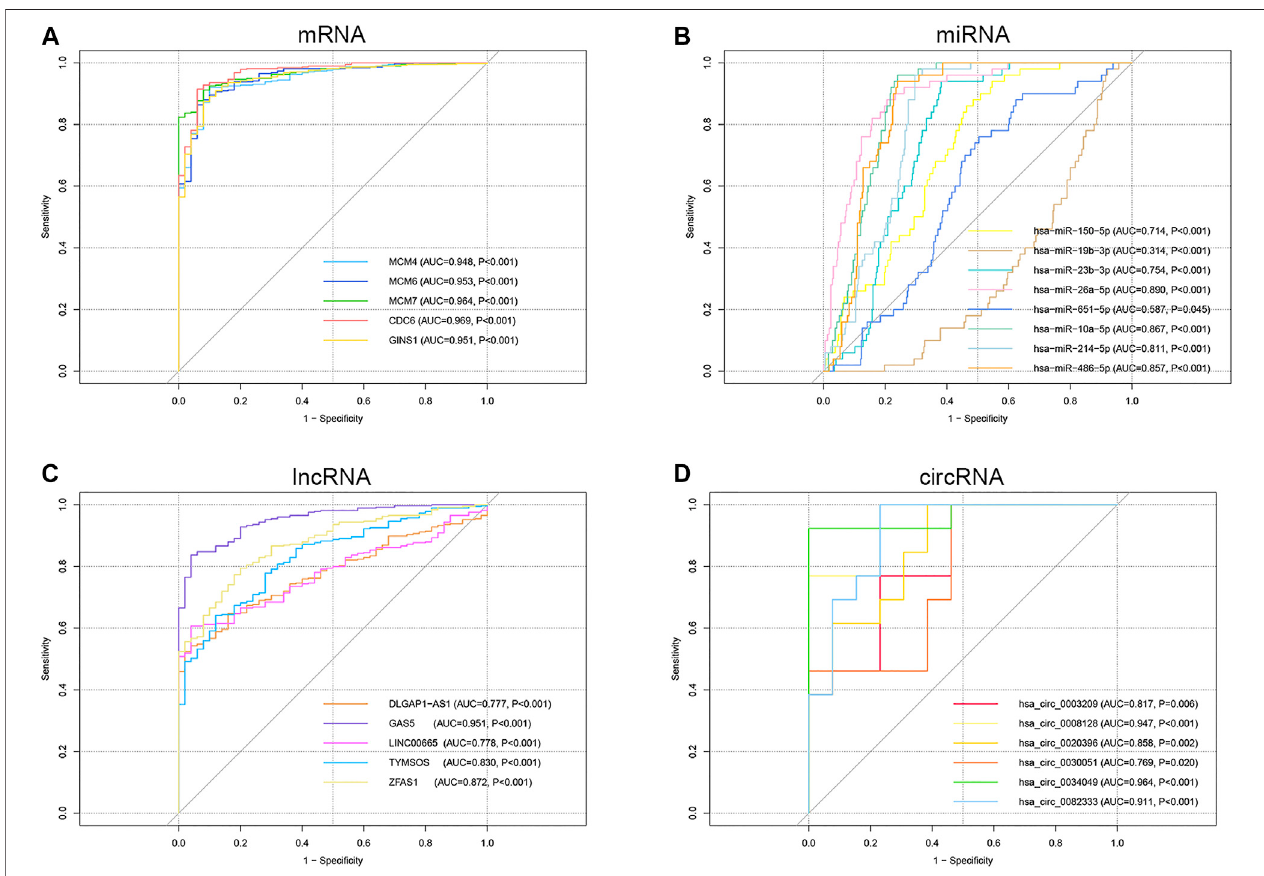
FIGURE 8 | ROCcurveanalysis ofthe mRNA (A) , miRNA (B) , lncRNA (C) , and circRNA (D) in the ceRNA network. ROC, receiver operating characteristic; mRNA, messenger RNA; miRNA, microRNA; lncRNA, long non-coding RNA; circRNA, circular RNA; ceRNA, competing endogenous RNA; AUC, area under the ROC curve.